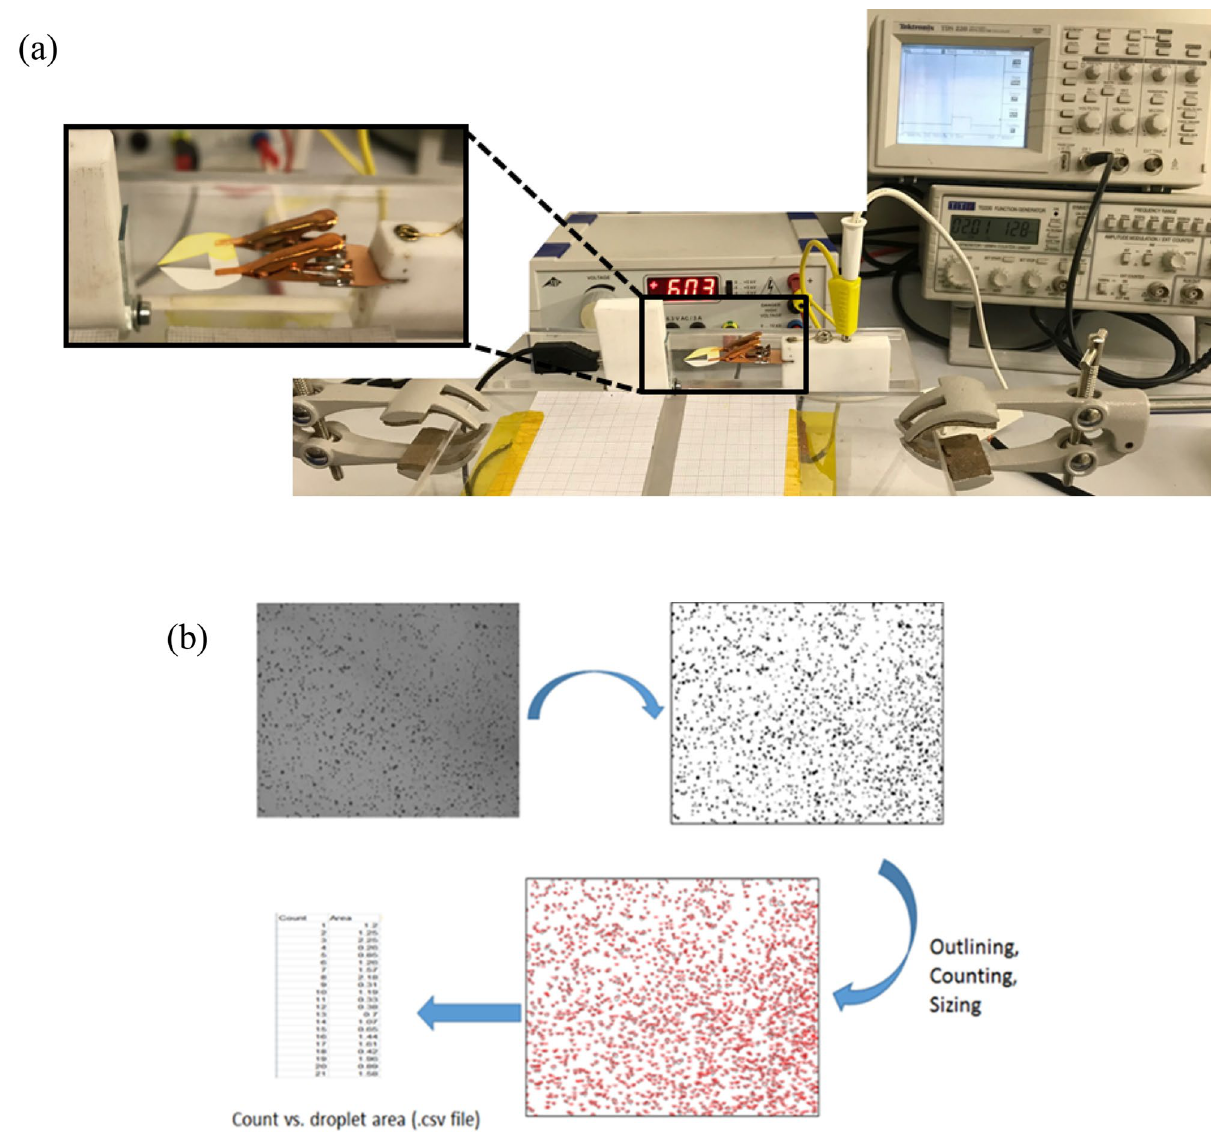
Figure 7. (a) Experimental set-up for the droplet distribution (e.g., dual-tip). (b) Typical work flow for the image processing